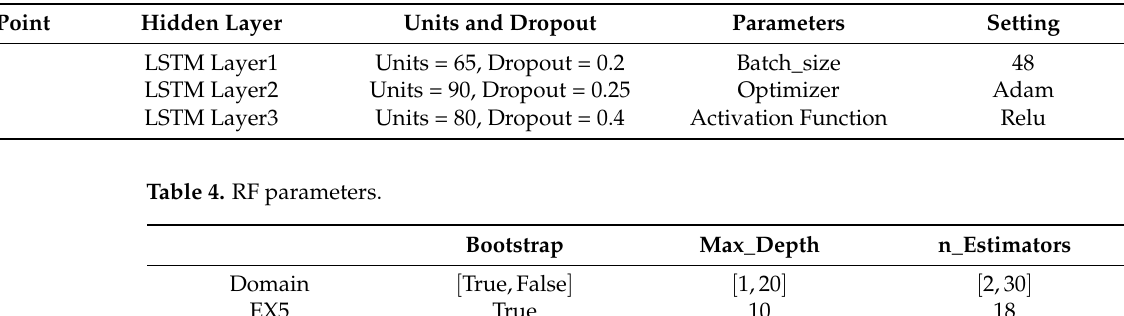
Table 3. LSTM parameters.